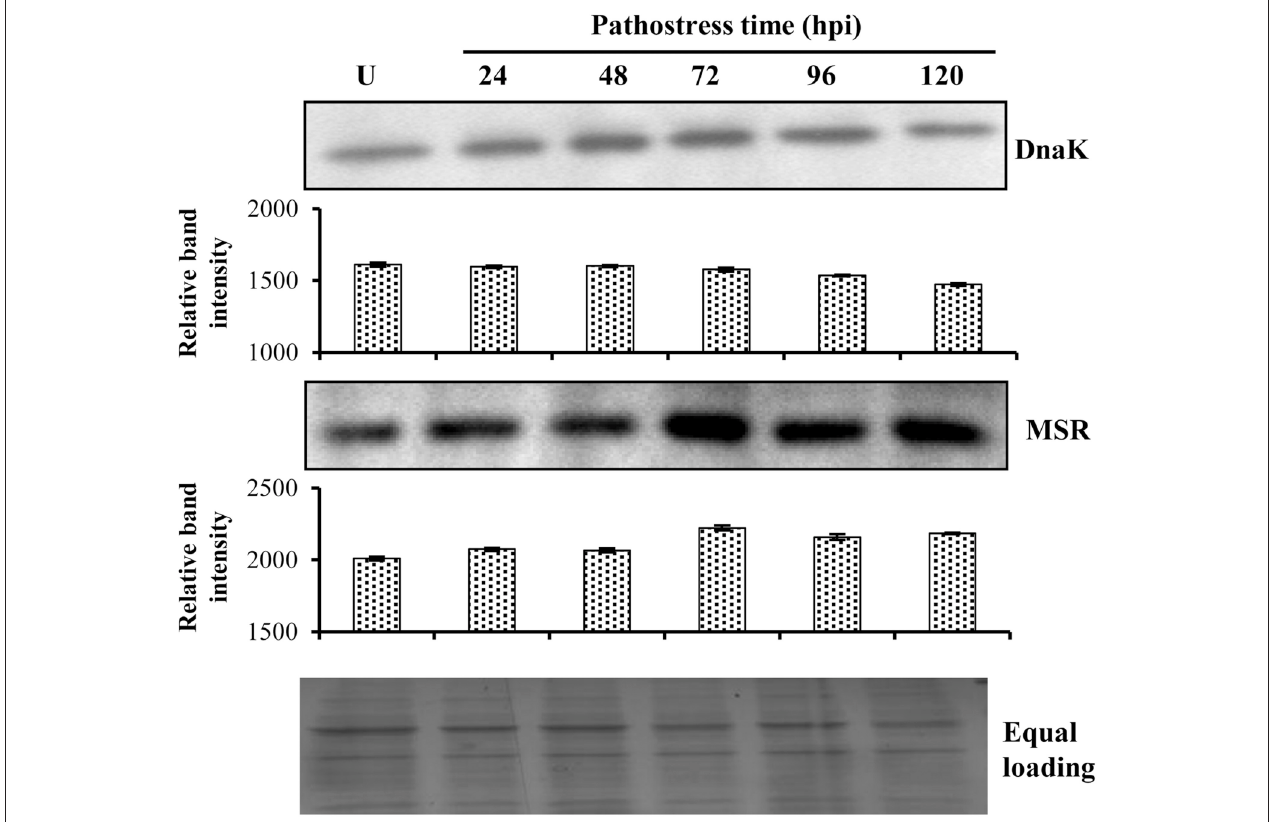
FIGURE 4 | Immunoblot analysis of selected PSRPs. An aliquot of 50 µ g soluble proteins was separated by 12.5% SDS–PAGE, blotted onto Hybond-C membrane, processed for one-dimensional immunoblot analysis and quantified by densitometry. Immunoreactive protein levels for DnaK and MSR was detected using the respective primary antibodies and signals were detected. U represents unstressed fruit. Commassie blue-stained gel indicates equal protein loading across time